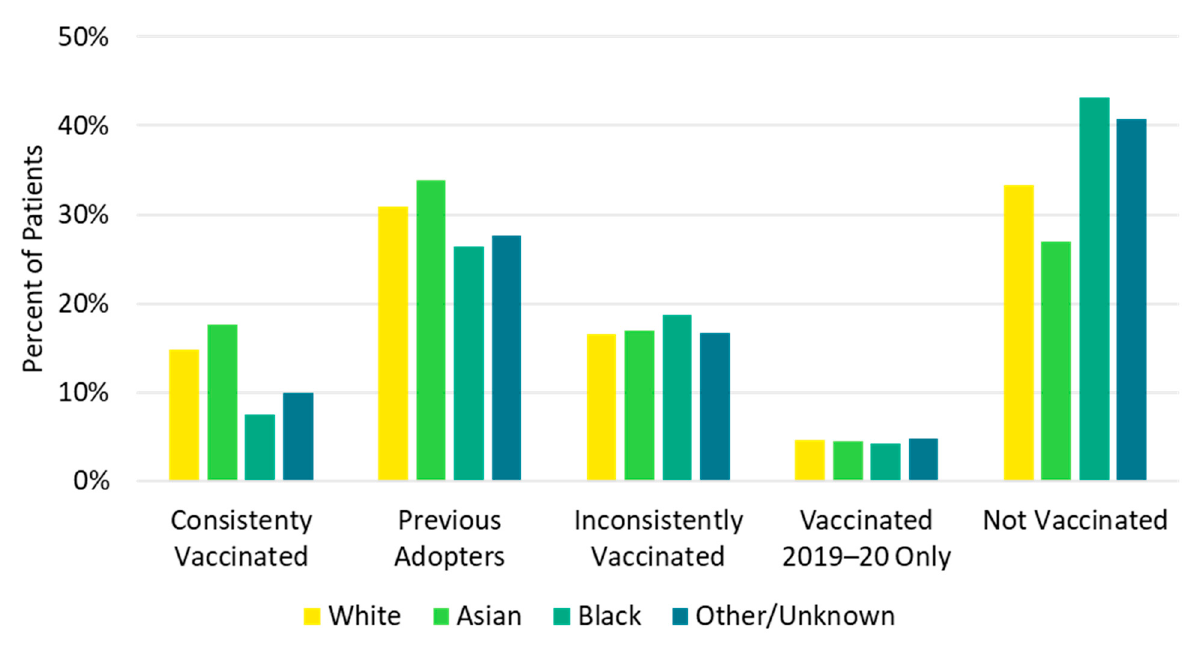
Figure 4. Vaccination history by age group: 2015–2016 through 2019–2020.